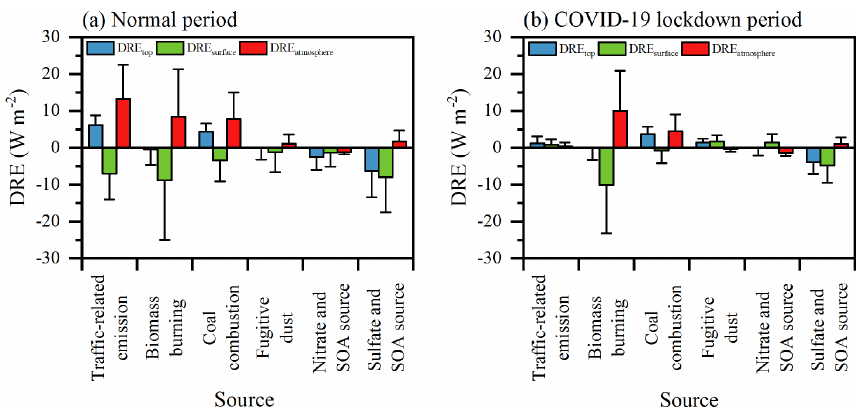
Figure 8. Direct radiative effect (DRE) of aerosol from traffic-related emissions, biomass burning, coal combustion, fugitive dust, the nitrate and SOA source, and the sulfate and SOA source at the Earth’s surface, the top of the atmosphere, and in the atmosphere during the normal (a) and COVID-19 lockdown (b)